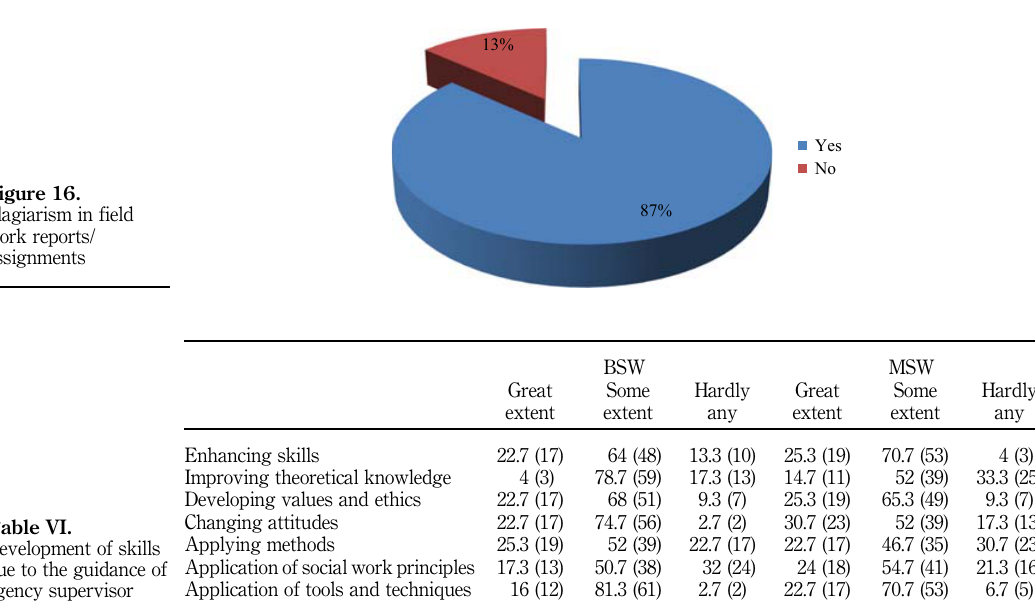
Table VI. Development of skills due to the guidance of agency